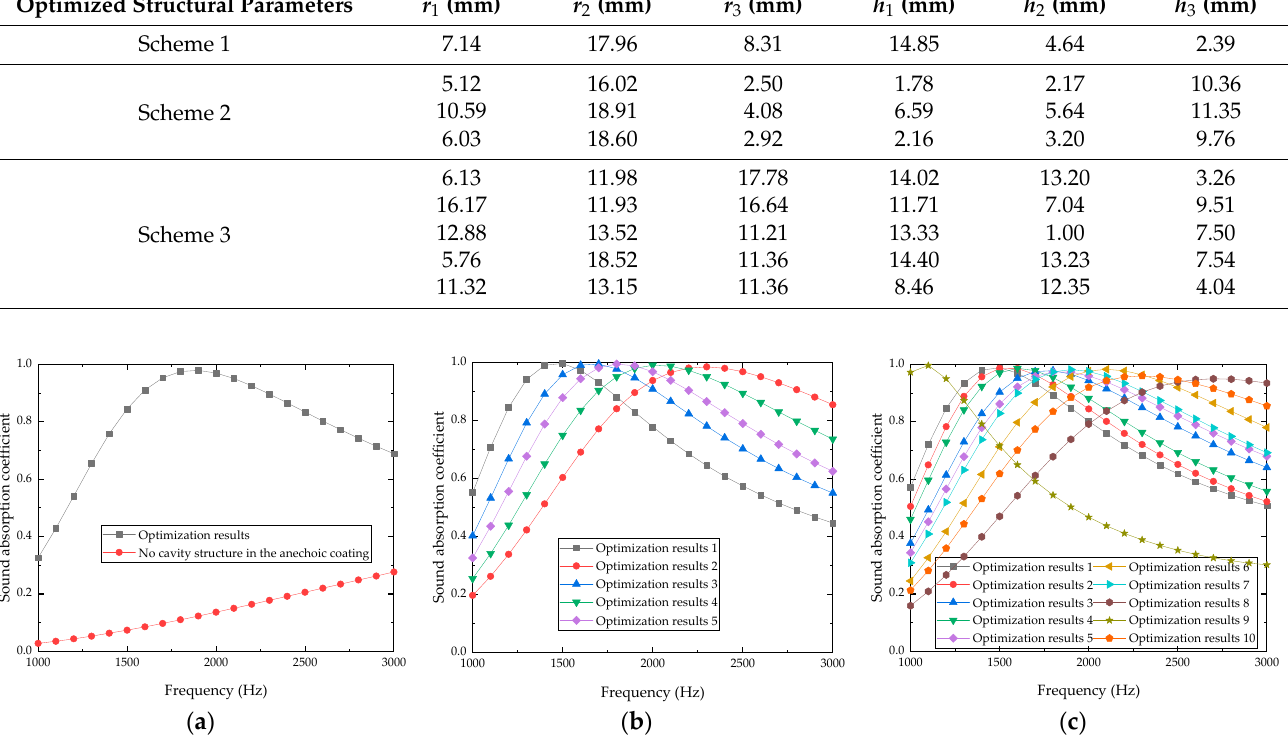
Figure 10. Optimized results, ( a ) Scheme 1; ( b ) Scheme 2; ( c ) Scheme 3.